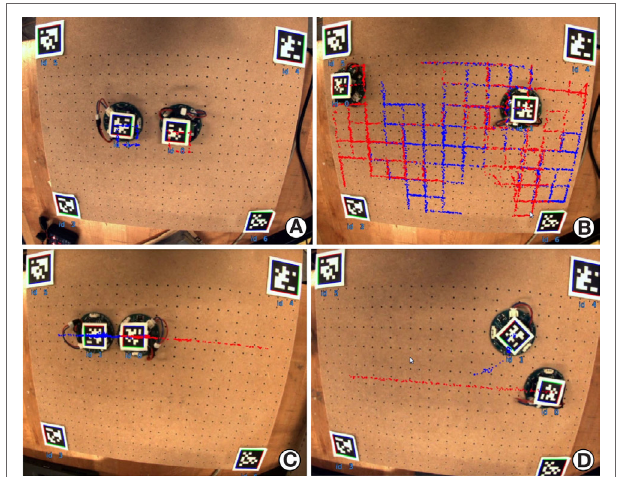
FigUre 7 | Demonstrations of the locomotion capabilities of multiple HoverBots. (a) Two HoverBots circle in formation until they are unsynchronized—video SV1. (B) Two HoverBots move randomly, collide, and recover—video SV2. (c) Two HoverBots collide frontally with one another— video SV3. (D) One HoverBot collides with a passive HoverBot—video SV4. Red and blue trajectories depict the HoverBot’s movements over